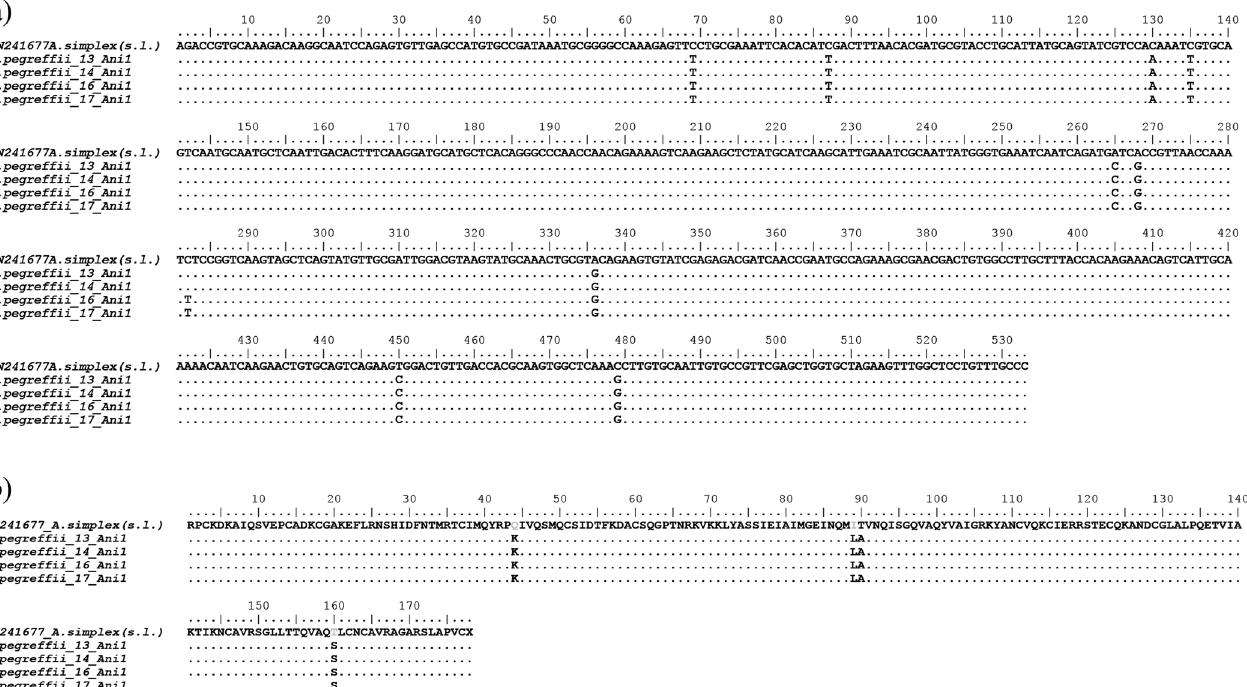
Figure 1. Nucleotide and amino acid sequence alignment of A.peg-1 cDNA. (a) Nucleotide sequence alignment obtained from A. pegref fi i larvae from the present study in comparison with those previously deposited in GenBank as A. simplex (s. l.) (Accession No. JN241677). Dots indicate identity with the consensus sequence. (b) Amino acid sequence alignment of the deduced amino acid sequences of the A.peg-1 allergen showing the variable sites between A. pegref fi i , and previously reported A. simplex (s. l.). Dots represent residues identical to the reference Ani s 1